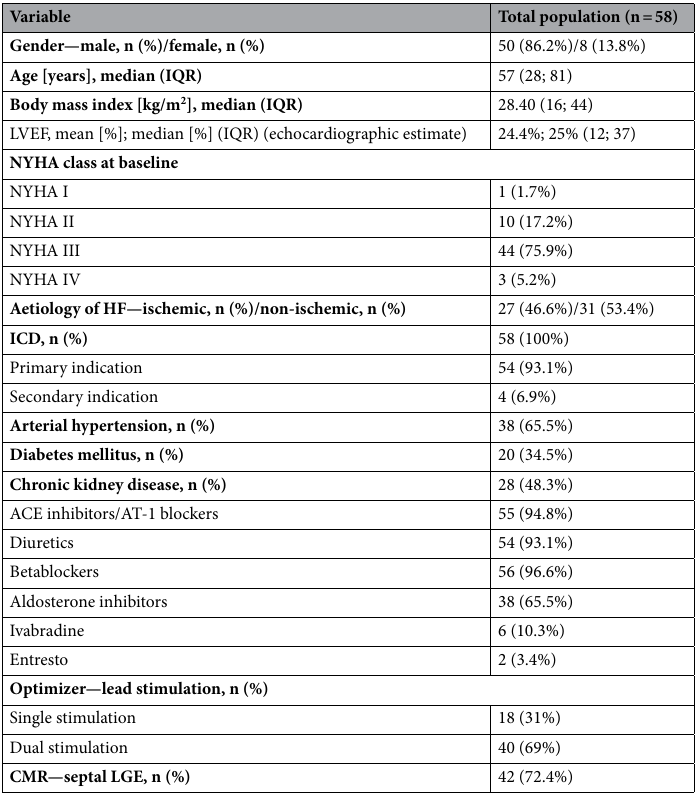
Table 1. Baseline characteristics. LVEF left ventricular ejection fraction, NYHA New York Heart Association, HF heart failure, ICD implantable cardioverter-defibrillator, COPD Chronic obstructive pulmonary disease, ACE angiotensin converting enzyme, AT‑1 angiotensin receptor, CMR cardiac magnetic resonance, LGE late gadolinium enhancement.